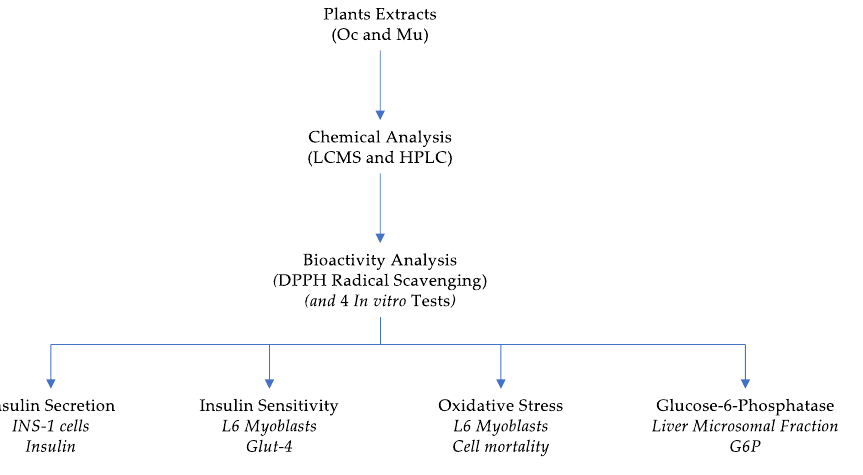
Figure 1. Workflow Figure 1. Workflow diagram.